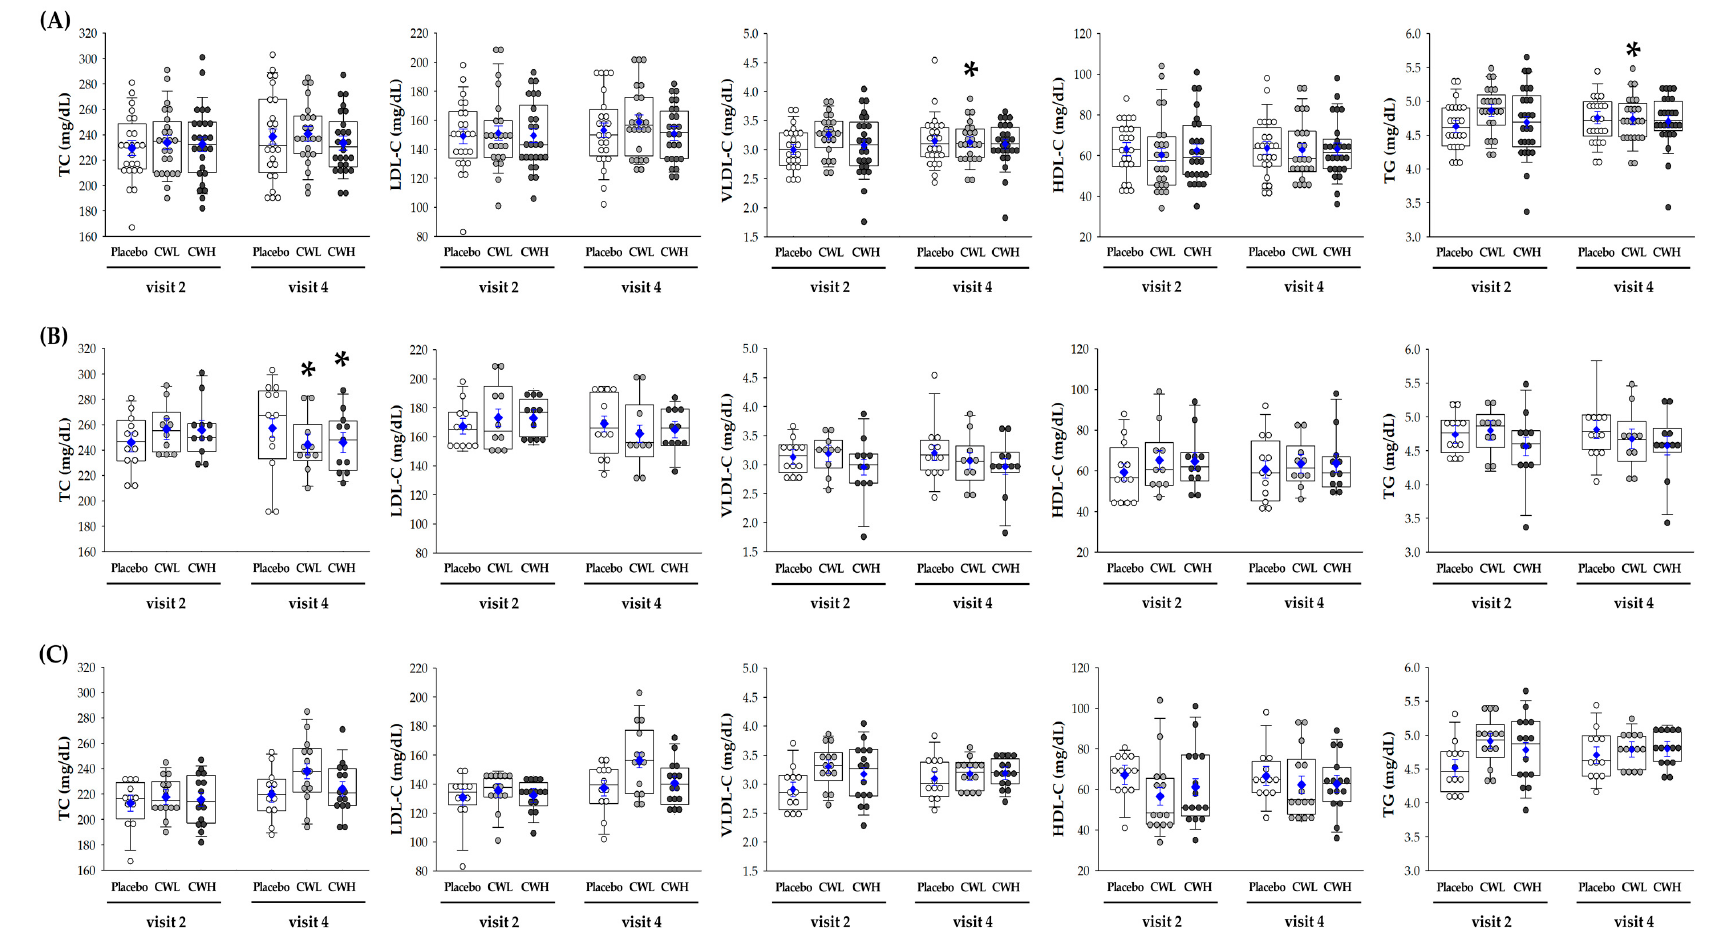
Figure 3. Changes in the lipid profile from baseline to week-8 post treatment. ( A ) Lipid profile analysis of participants (placebo = 24, CWL = 24, CWH = 26); ( B ) high-level LDL-C subgroup (placebo = 12, CWL = 10, CWH = 11) with baseline LDL-C ≥ 150 mg / dL; ( C ) low-level LDL-C subgroup (placebo = 12, CWL = 14, CWH = 15) with baseline LDL-C < 150 mg / dL; * p < 0.05, Group*time e ff ect between placebo and CW